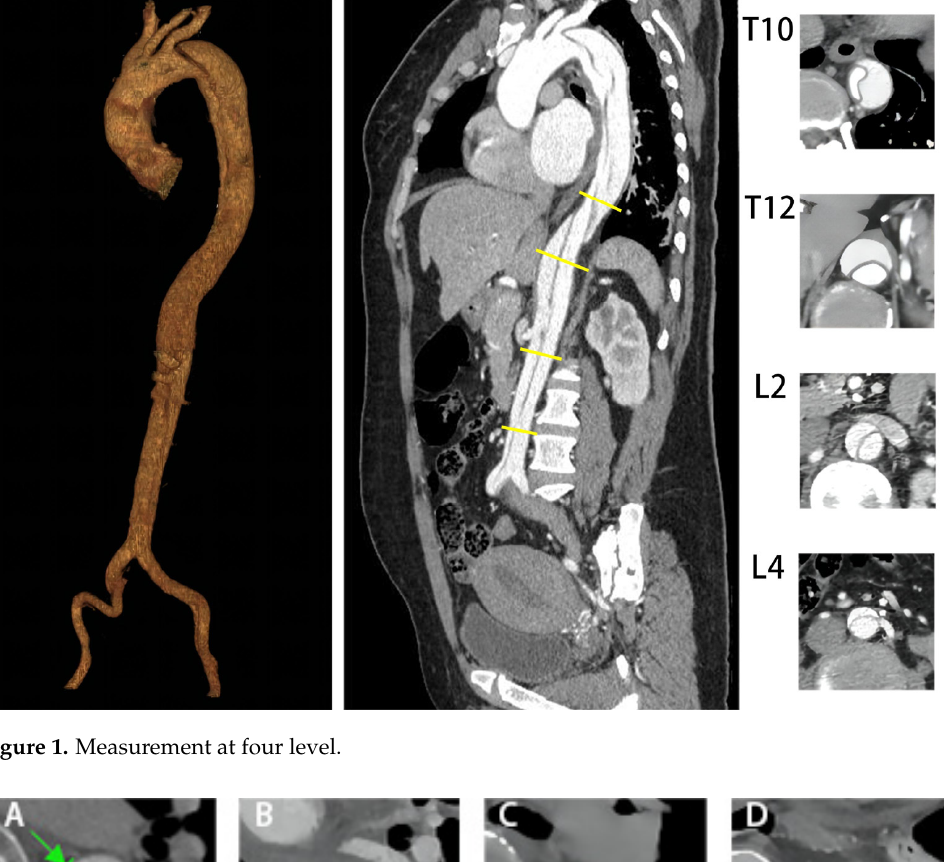
Figure 1. Measurement at four level.